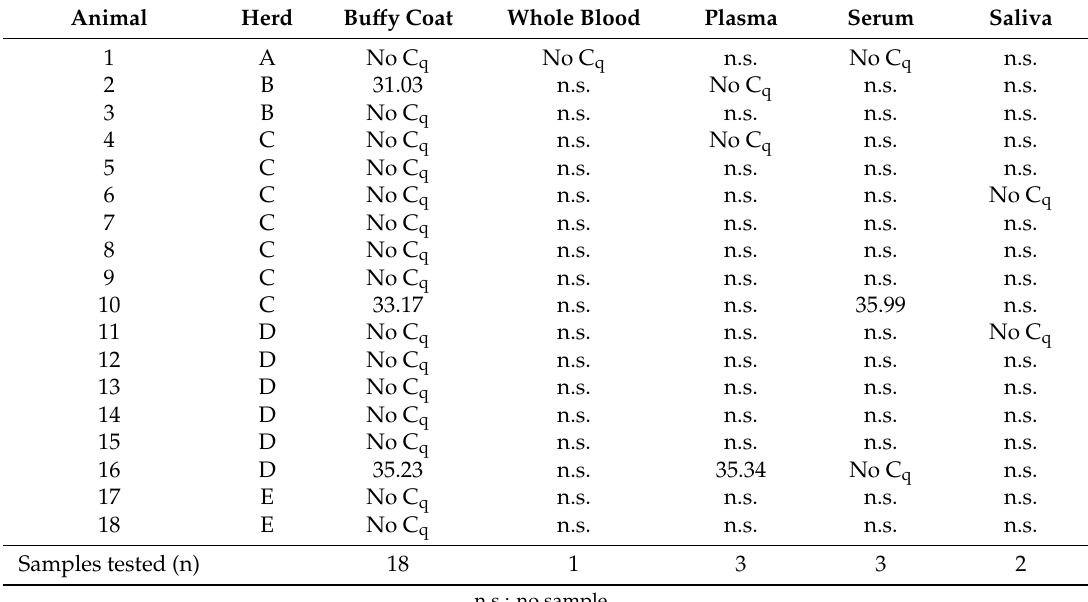
Table 4. C q values of the ovine gammaherpesvirus-2 (OvHV-2) PCR for samples from clinically a ff ected cattle. Animal